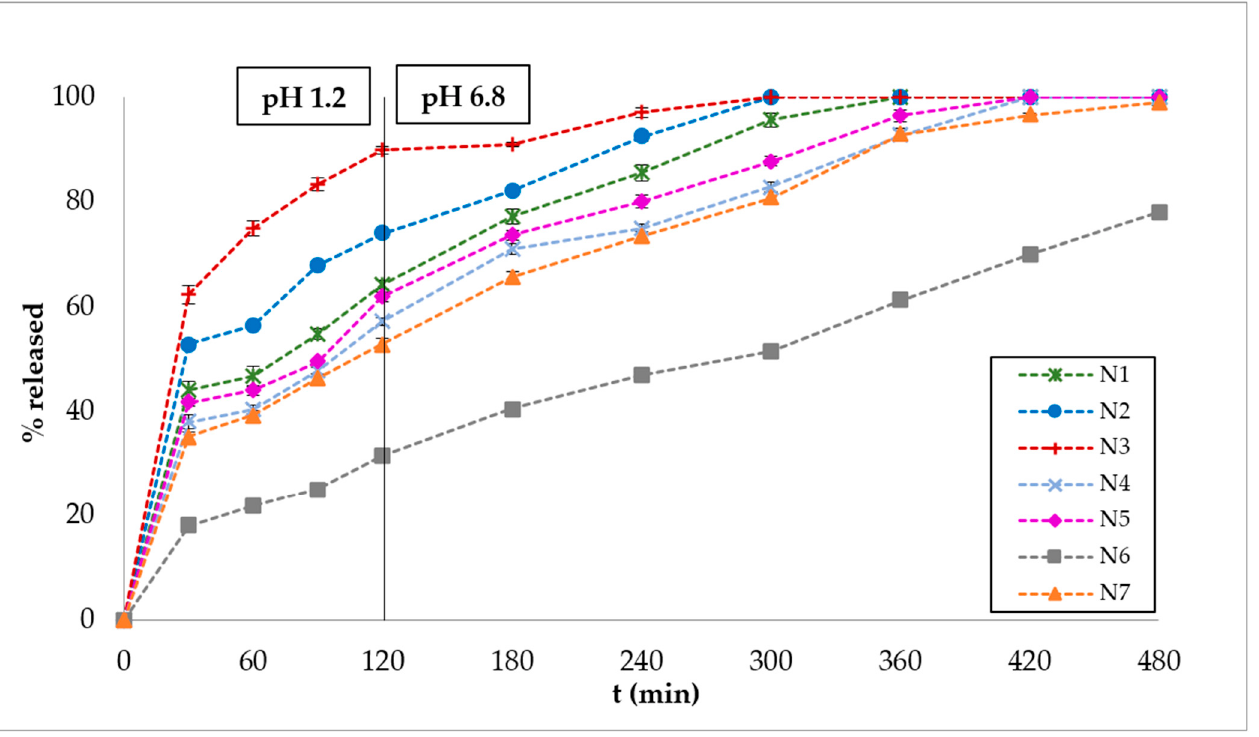
Figure 2. In vitro % release of bupropion hydrochloride (BUP . HCl) and the commercially available product (Wellbutrin ® XR 150 and 300 mg) vs. time Figure 1. 2 (0–120 min) and at pH 6.8 (120–480 min). The results denote the mean value ( n = 6, SD < 2).